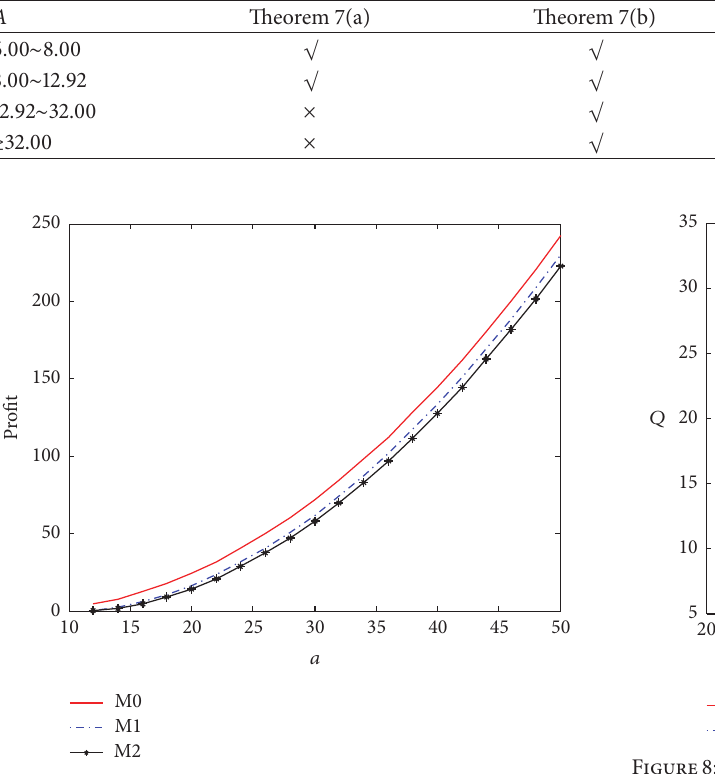
Figure 7: Optimal expected profit comparison in models M0, M1, and M2.